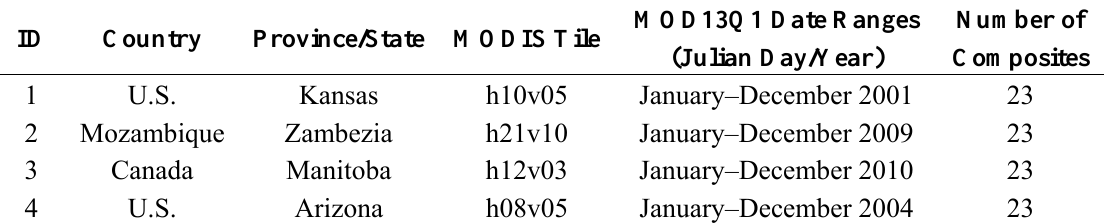
Table 3. List of MODIS tiles used for each study